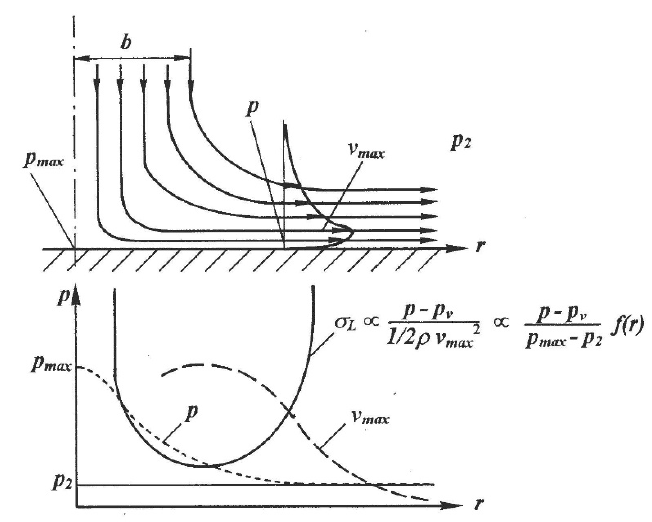
Figure 10. Schematic diagram of local cavitation number [72].